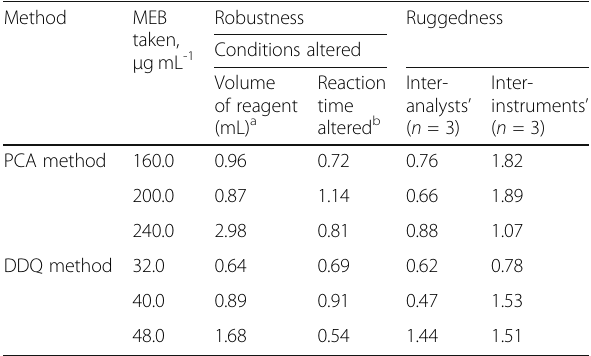
Table 2 Calibration, regression, quantitative and sensitivity parameters